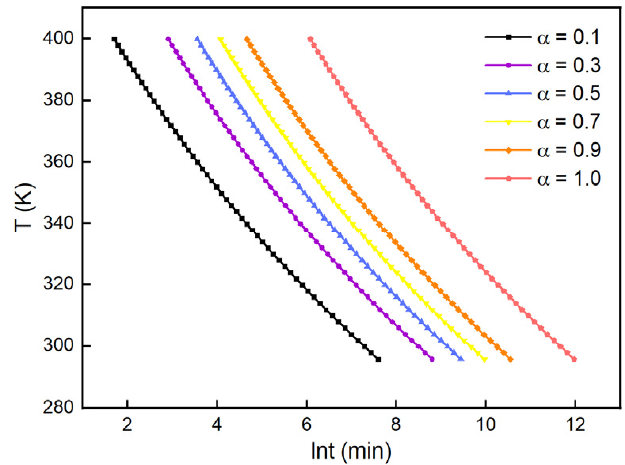
Figure 6. Iso–curing curves for the H 6 XDI/BES system. Figure 5. Iso–curing curves for the H